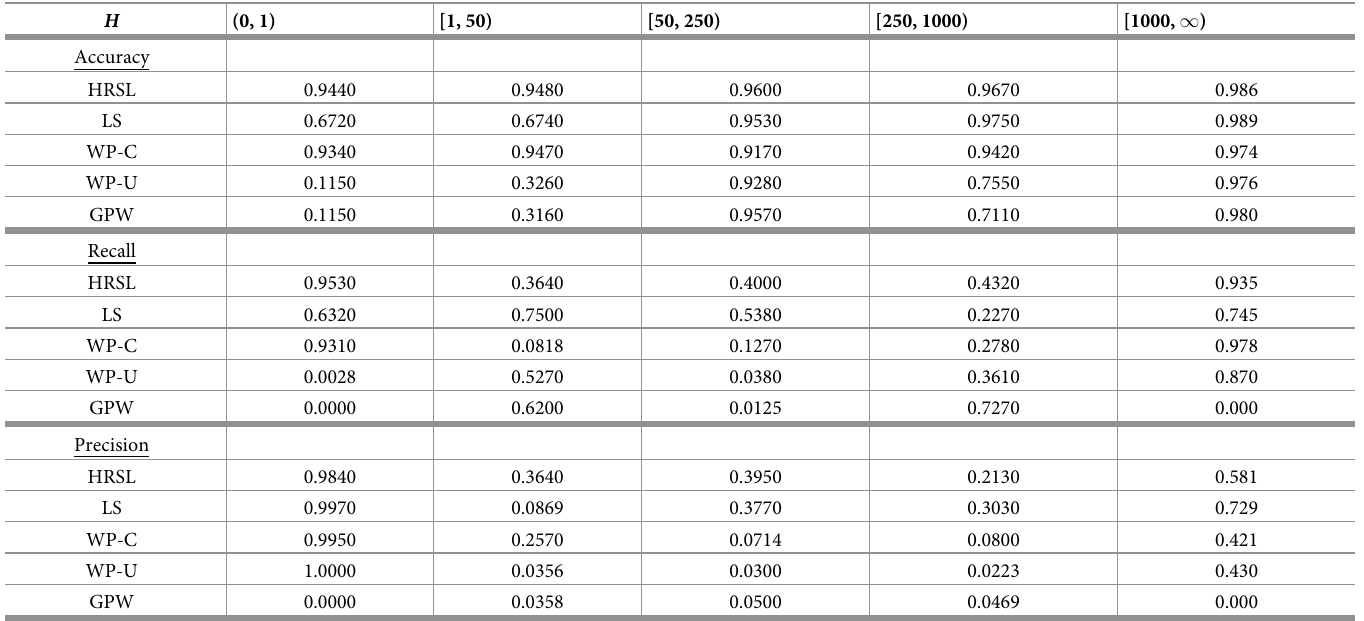
Table 4. The accuracy, recall, and precision for the population classifications shown in the header and illustrated in Fig